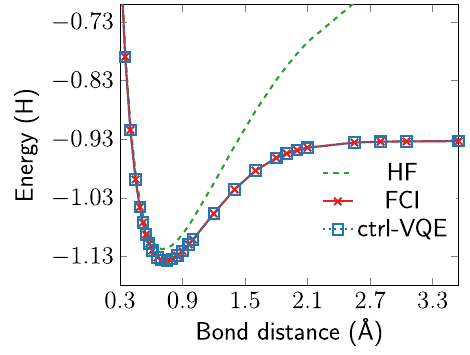
Fig. 1 Bond dissociation curve of H 2 molecule. ctrl-VQE energies are computed using square pulses with two time segments.